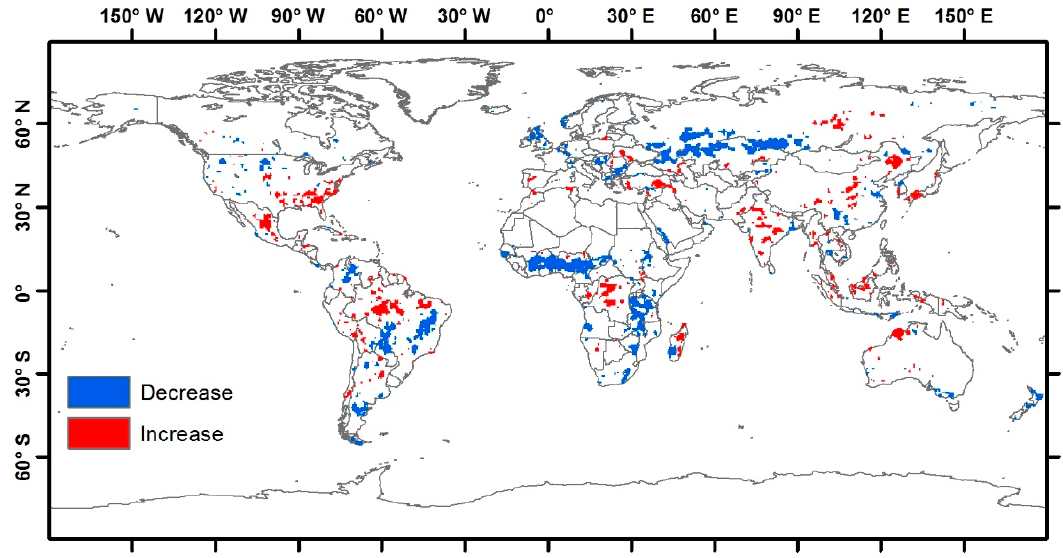
Figure 6. Significant trends of BA (with a confidence level of 95%) in the short-term series (2001–2018) for the low-resolution BA product (FireCCILT11).